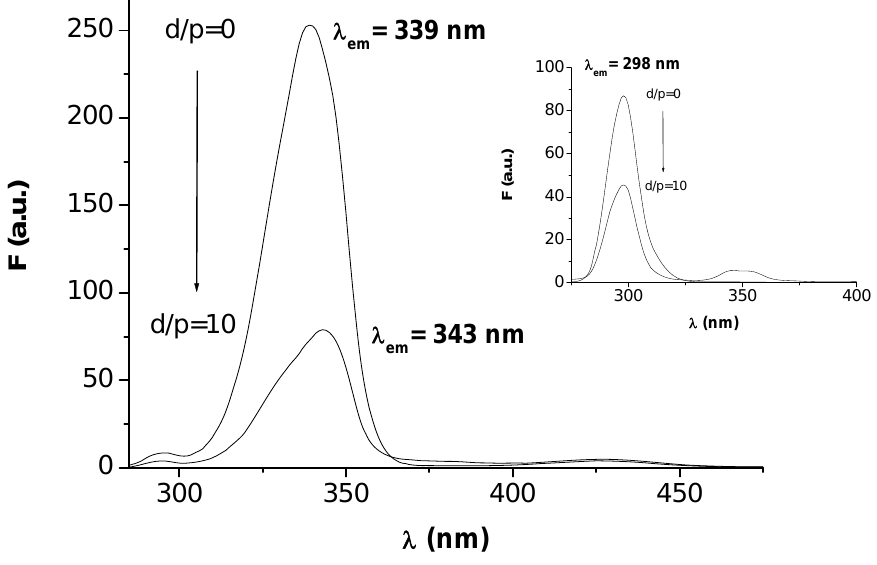
Figure 4 . The HEBID effect on the synchronous fluorescence emission of HSA ( Δλ = 60 nm). Inset: Δλ = 15